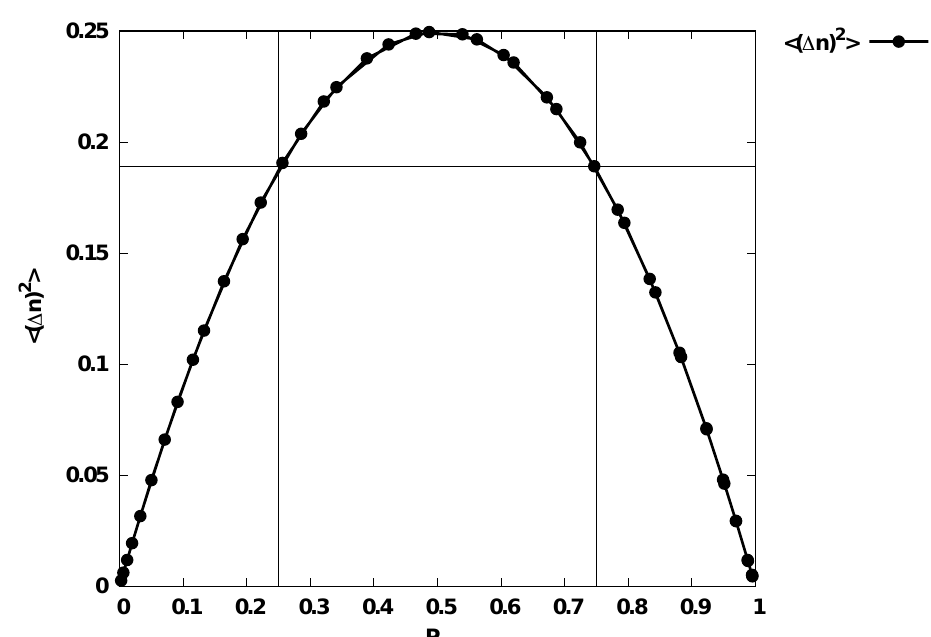
Figure 5. Variance of the experimental photon counting versus the probability of transmission. The horizontal line at (cid:104) ( ∆ ˆ n ) 2 (cid:105) = 3/16, indicating the theoretical values for the noise associated to the photon counting noise for quantum chaos F = 1/4,3/4, corresponding to the transmission probabilities P T = 3/4,1/4,